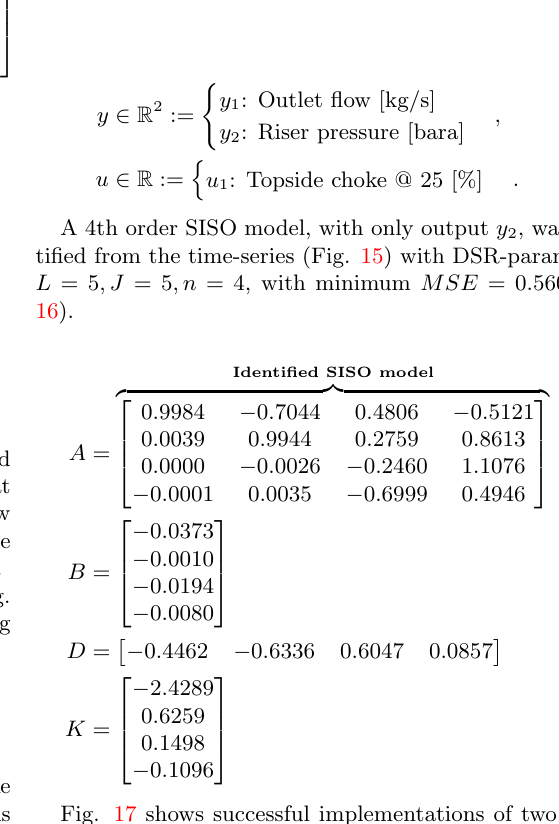
ent control strategies; LQR and PI. Both controllers